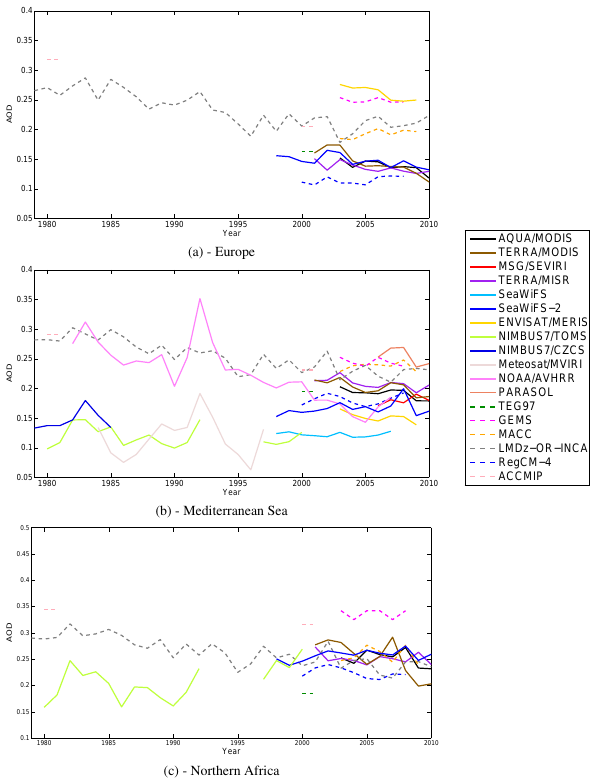
Fig.13. AODannualaveragesforeachdataset(satellitesandmodels)overtheEuropeancontinent(region8+9+10,top),theMediterranean Fig. 13. AOD annual averages for each dataset (satellites and Sea(region5+6,middle)andNorthernAfrica(region1+2,bottom)between1979and2010 models) over the European continent (region 8+9+10, top), the Mediterranean Sea (region 5+6, middle) and Northern Africa (re- over the whole 1979-2009 period, we resort to using model trend has been noticed for BC and OR aerosols over Europe 1140 data from the ACCMIP intercomparison exercise. Table 5 andtheMediterraneanSea(theACCMIPmeantrendis-0.00 gion 1+2, bottom) between 1979 and 2010. presents the sulfate AOD differences between the timeslices for BC and OR). 2000 and 1980 for each ACCMIP model. The decrease in 1135 To sum up, Figures 12 and 13 show a strong dispersion sulfate AOD ranges from -0.05 to -0.19 over Europe, and between the different products in AOD before the 2000s. from -0.03 to -0.08 over the Mediterranean Sea. LMDz-OR- INCAisamedianmodel,showingsulfatetrendsclosetothe ACCMIP mean. It should also be noted that no significant